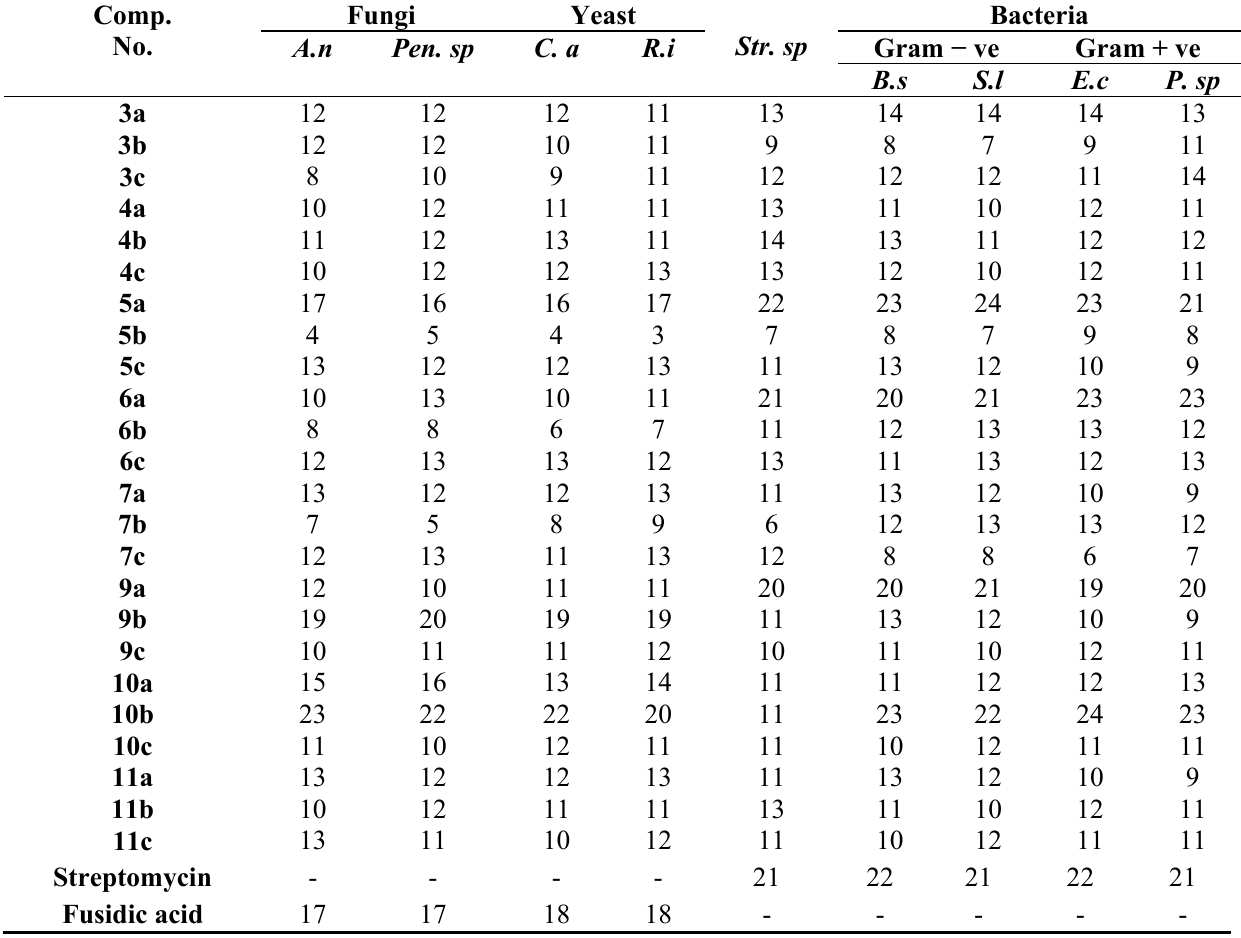
Table 3. Antimicrobial activities of the newly synthesized compounds 3 – 11 .